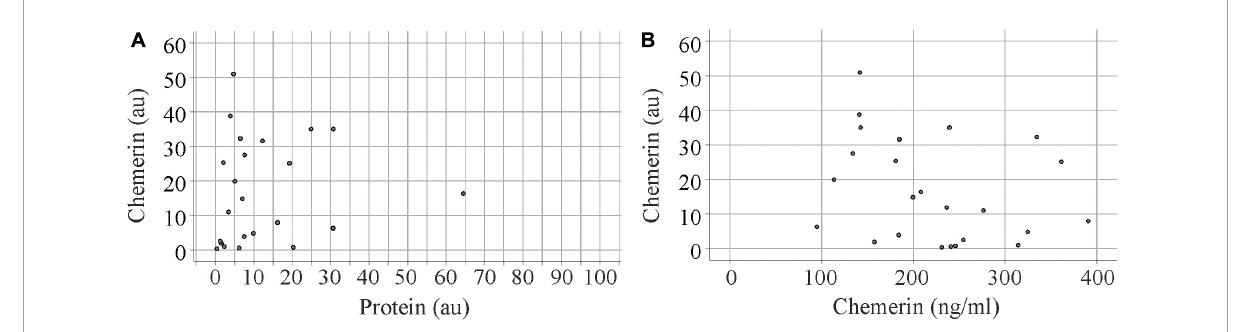
FIGURE3 Correlation analysis of urinary chemerin protein with total protein levels and serum chemerin. (A) Correlation of urinary chemerin protein determined by immunoblot and total protein in urine. Data of one patient is not shown in the figure because of the high protein content of this urine sample. (B) Correlation of urinary chemerin protein determined by immunoblot and serum chemerin measured by enzyme-linked immunosorbent assay